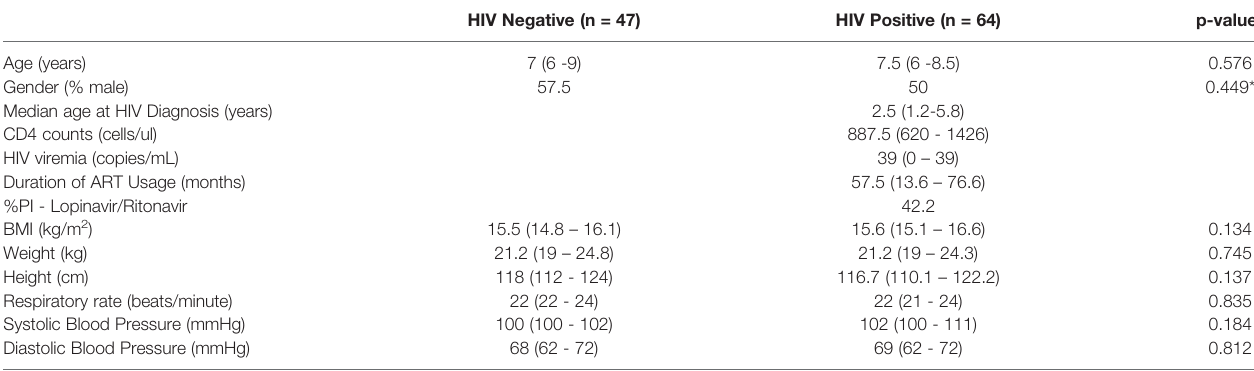
TABLE 1 | Clinical parameters of the study participants.